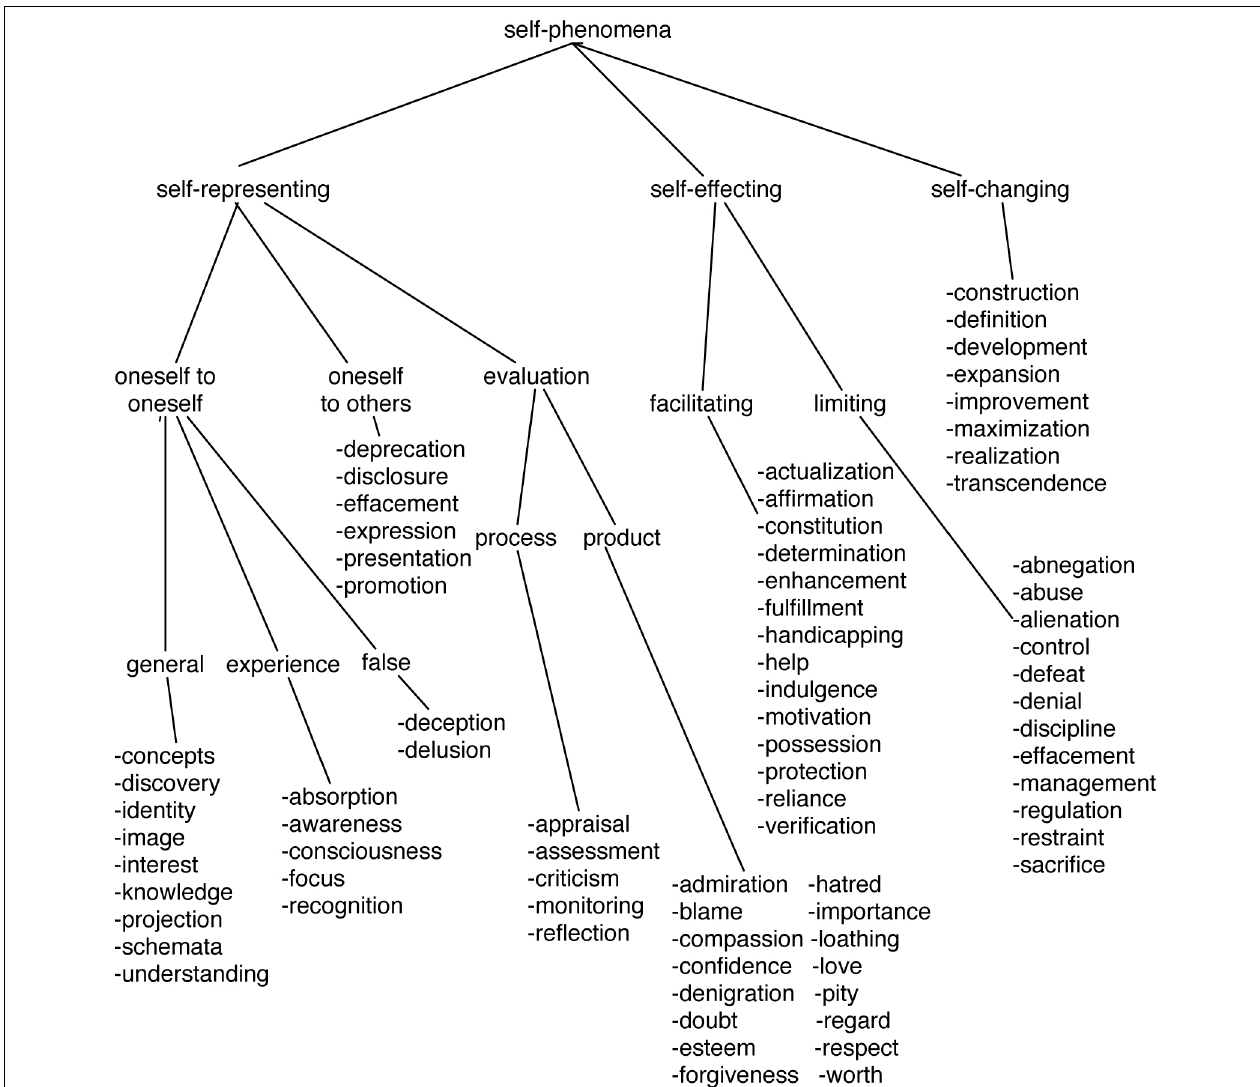
FIGURE 1 | Grouping of many self-phenomena into six main classes: self-representing (with three sub-categories), self-effecting (with two sub-categories), and self-changing. Source: Thagard